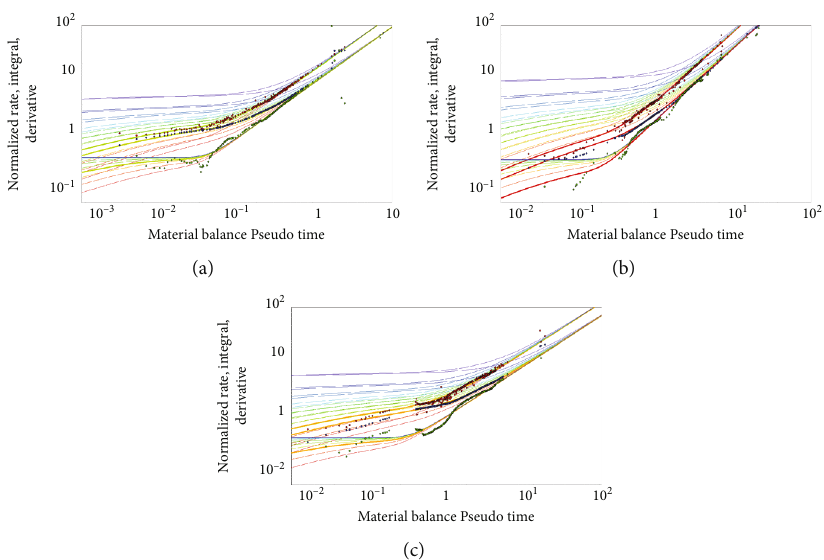
Figure 10: Fitting of NPI method-type curve and production data: (a) L2-3, (b) Y2-8, and (c) Y4-5.